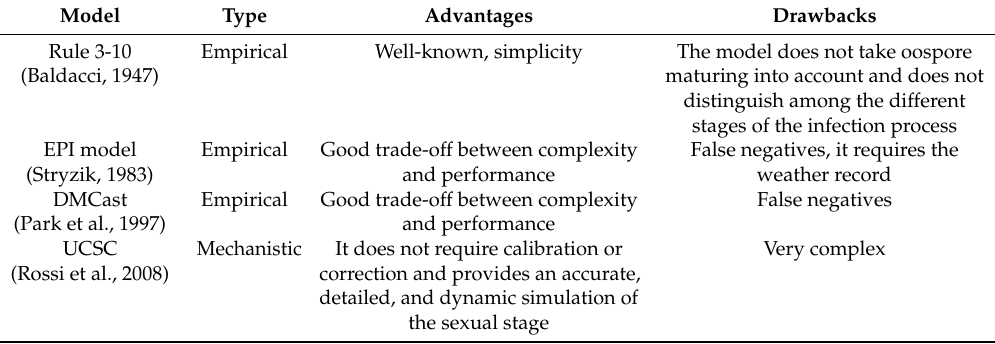
Table 2. Main characteristics of the different epidemiological models for preventing downy mildew.